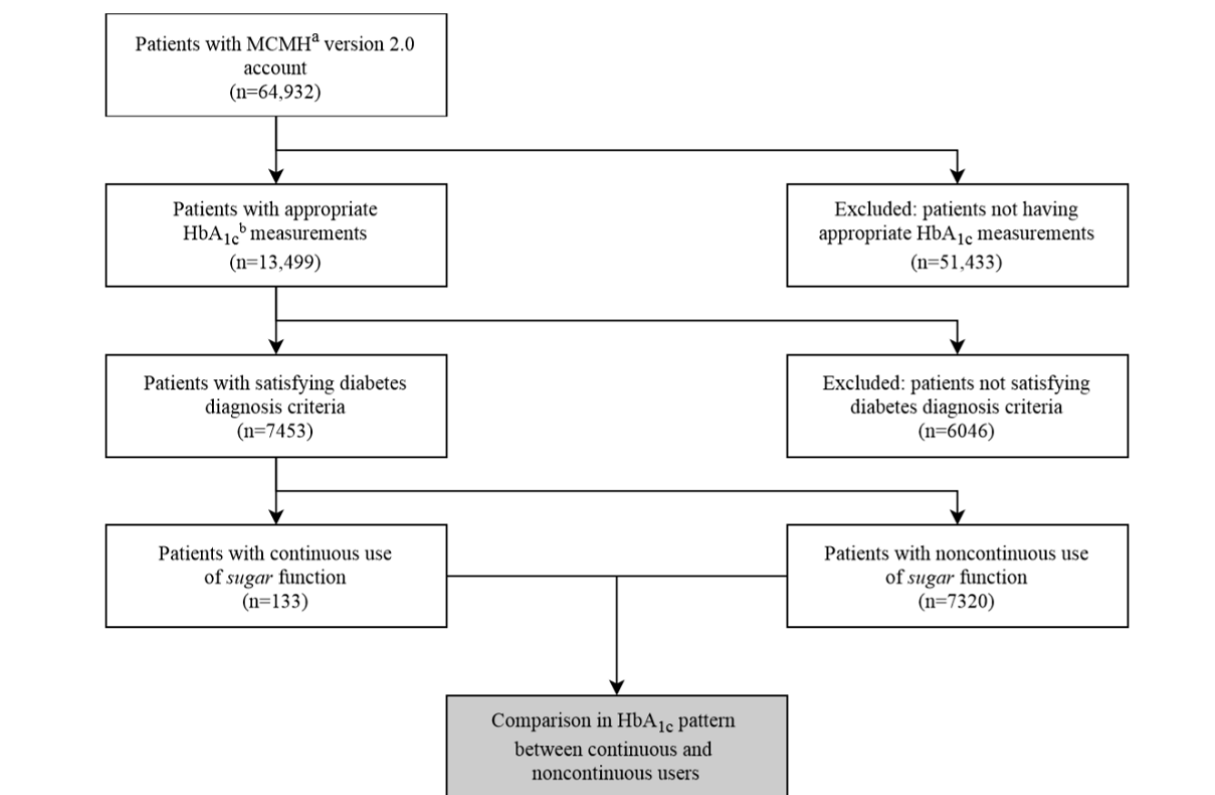
Figure 2. Patient inclusion and exclusion criteria (white boxes) and flow through the study. The gray box shows user hemoglobin A 1c (HbA 1c ) analyses. Criteria for appropriate HbA 1c measurement: two or more HbA 1c measurements, duration of the first and last measurement over 100 days, and creating My Chart in My Hand version 2.0 account during HbA 1c measurement. Criteria for diabetes diagnosis: having International Classification of Diseases 10th Revision code E08, E09, E10, E11, or E13 or first HbA 1c measurement ≥ 6.5%. Criteria for continuous use of sugar function: patient-generated health data entered in the sugar function at least once per week and used for at least 28 days. a HbA 1c : hemoglobin A 1c ; b MCMH: My Chart in My